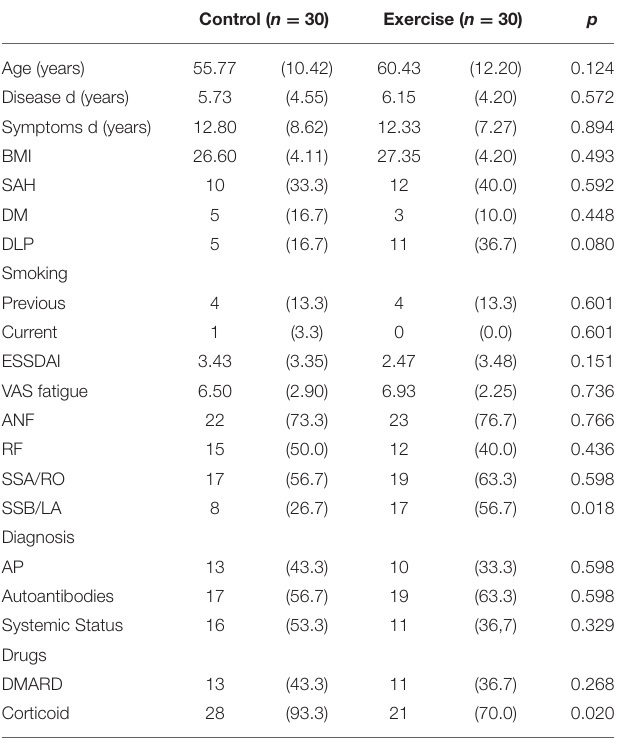
TABLE 1 | Clinical and demographic characteristics of the EG and CG groups at